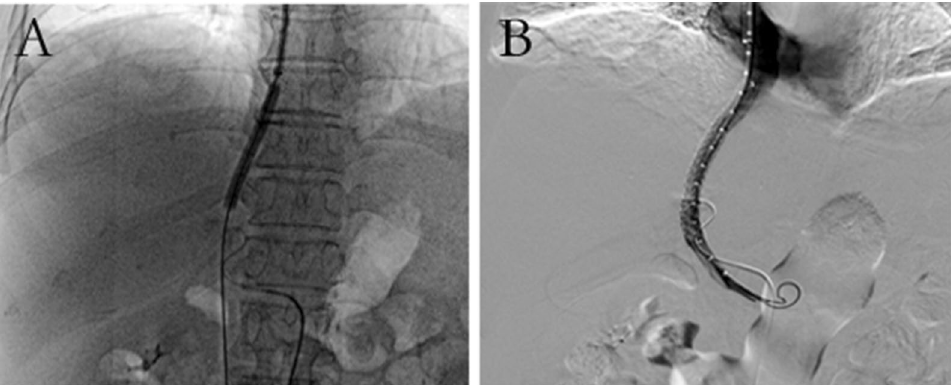
Figure 3. Digital subtraction angiography images from a 61-year-old female patient receiving transjugular intrahepatic portosystemic shunt treatment. ( A ) After successful puncture of the portal vein, the puncture tract was expanded with a balloon. ( B ) Portal vein angiography image after portal vein stent implantation.